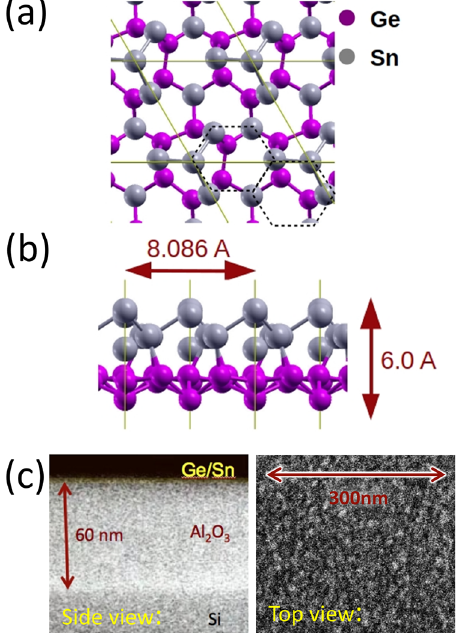
Fig. 1 Theoretical geometry and SEM image. a top-view of the theoretical geometrical structure of free-standing GeSn bilayer. b Side view of the relaxed theoretical geometrical structure of free- standing GeSn bilayer. c Side-view and top-view SEM images of the GeSn bilayer deposited on a 60 nm thick Al 2 O 3 layer, which was grown on a n-doped Si